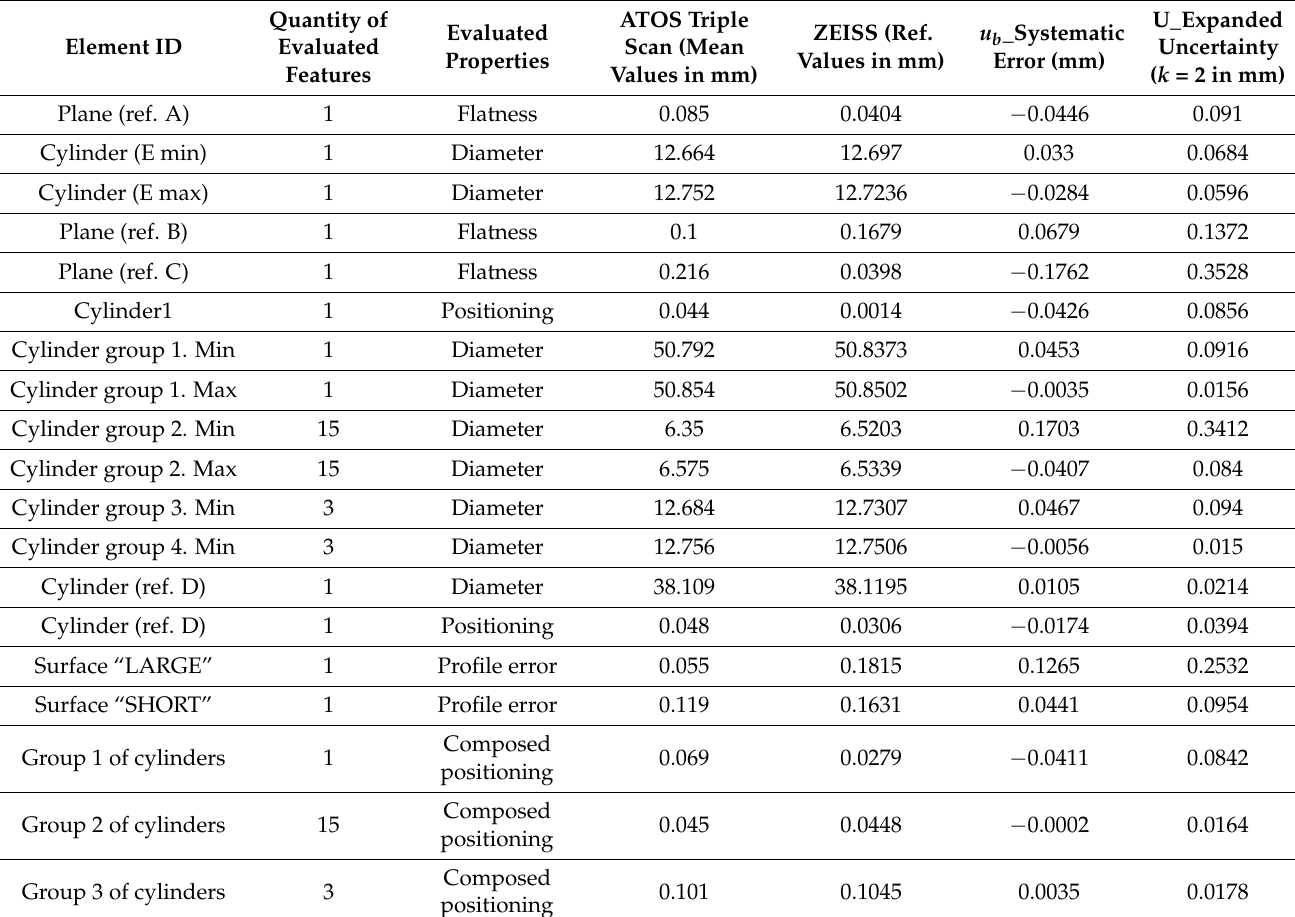
Table 4. (U) Expanded measurement uncertainty assessment results. Uncertainty